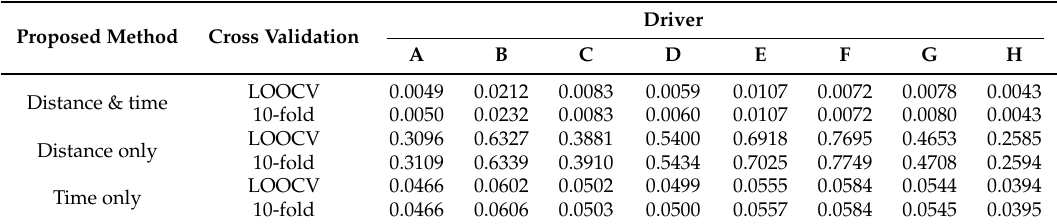
Table 5. Results of the RMSE for each of the eight drivers in all the scenarios based on the proposed methods. (RMSE: the root mean square error, time: time of movement) Proposed Method